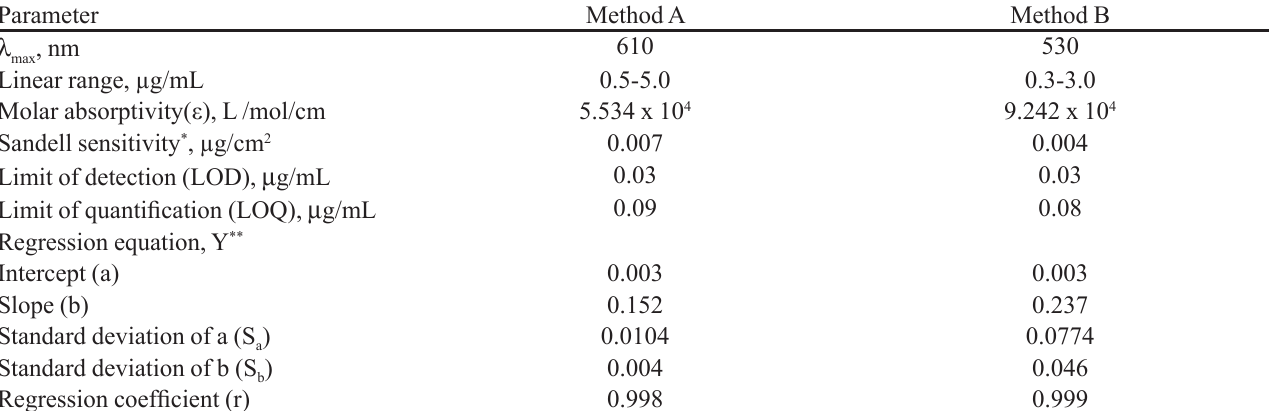
TABLE II - Sensitivity and Regression Parameters Parameter